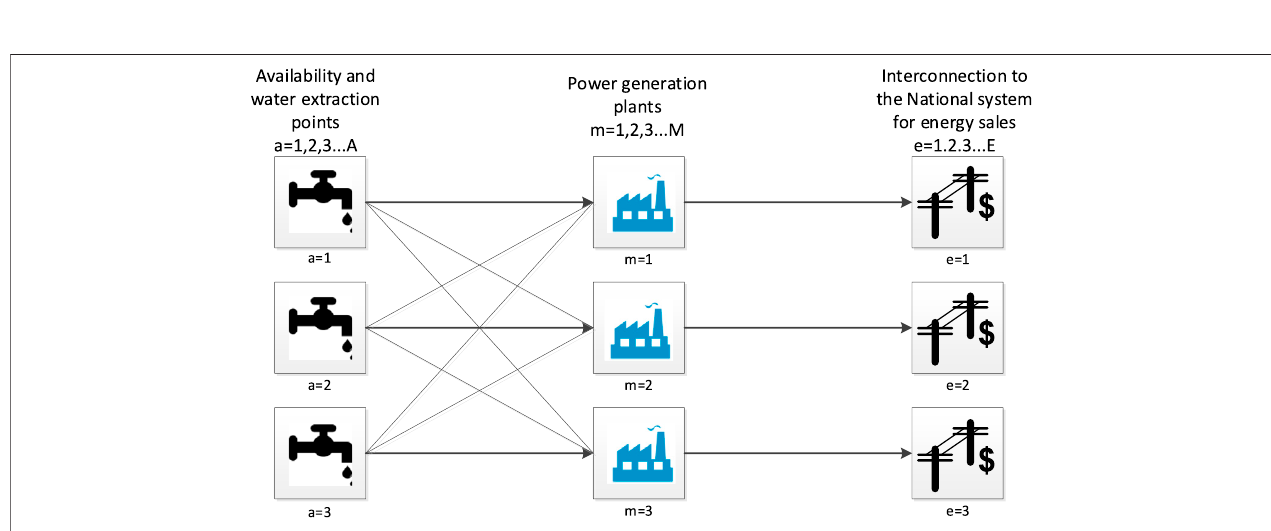
FIGURE 2 | Superstructure for the case study for the optimal location of power generation plants with solar concentrators.